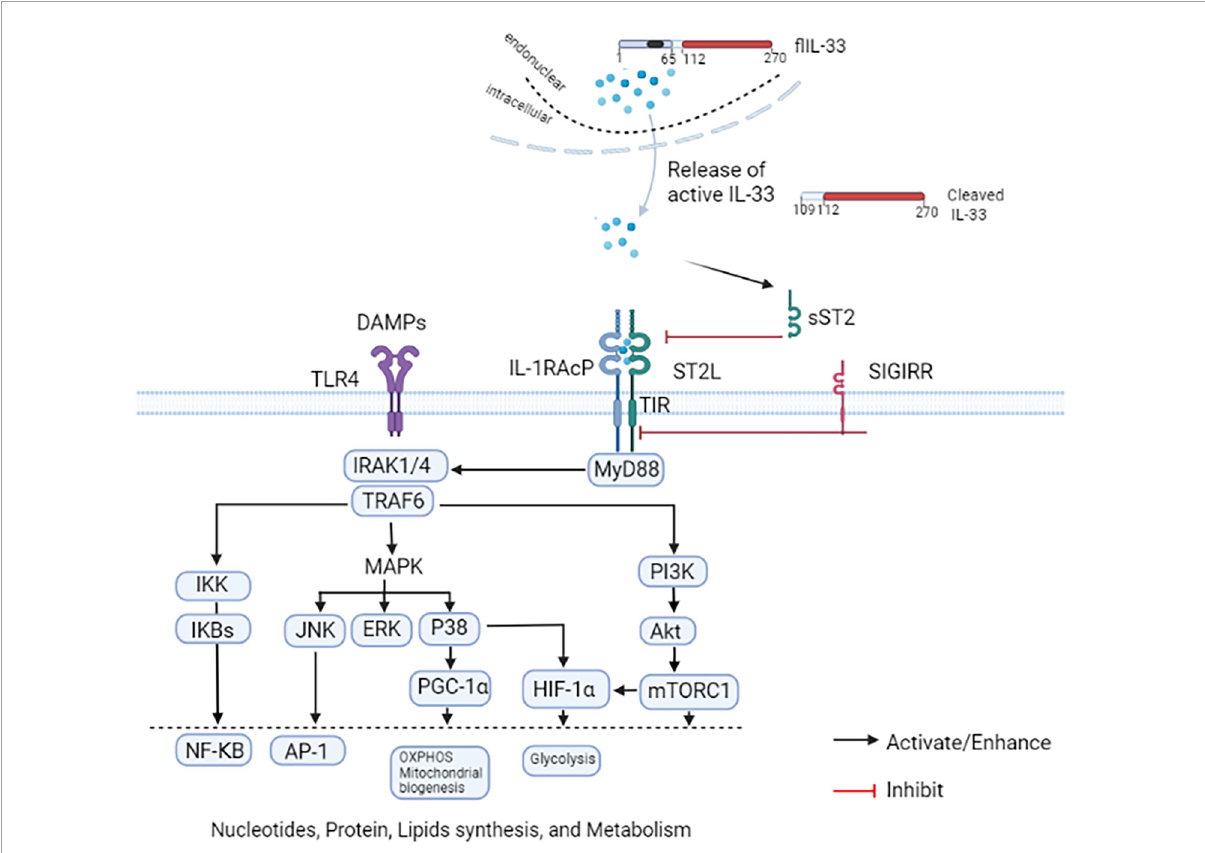
FIGURE3 IL-33/ST2 axis. IL-33 is normally localized in the cell nucleus. The full-length (fl) IL-33 protein is released in the endoplasmic reticulum-Golgi independent but ATP-dependent pathway during cell damage or necrosis. The flIL-33 is then cleaved by inflammatory proteases into a form with increased activity. A heterodimeric receptor complex is formed by IL-33 and ST2L with IL-1R accessory protein (IL-1RAcP) The complex activates the downstream MyD88 pathway, and then activates NF- κ B, AP-1, PGC-1 α , and HIF-1 α to promote gene, protein, and lipid synthesis as well as cellular metabolism. A single IL-1-associated receptor SIGIRR negatively regulates the IL-33/ST2 axis. NF- κ B and AP-1 are involved in the pathogenesis of various diseases by promoting inflammatory responses and inhibiting apoptosis. Activation of P38 can promote PGC-1 α , OXPHOS, and mitochondrial fission and fusion; it can also lead to the activation of HIF-1 α and enhancement of glycolysis. mTORC1 can also enhance HIF-1 α expression and glycolysis enhancement in